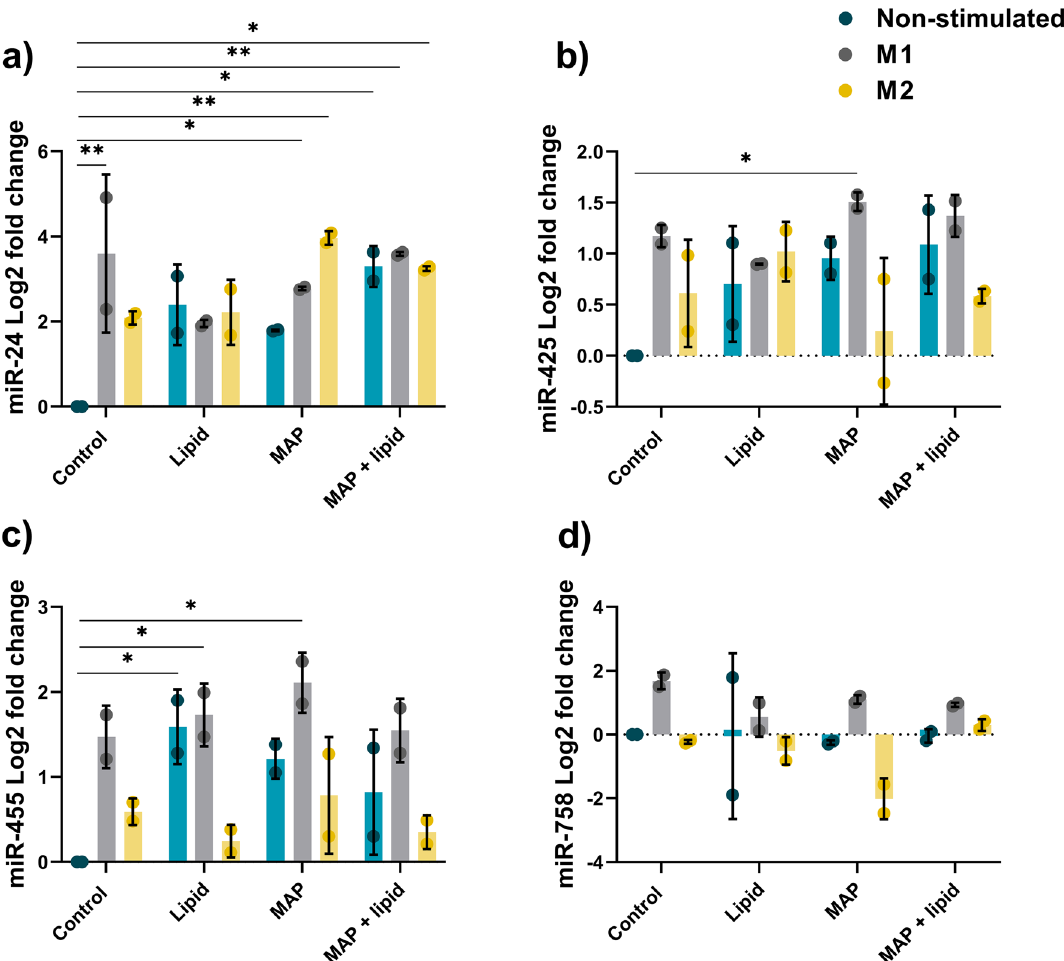
Figure 4. miRNA expression in MAP infected murine macrophages. RAW264.7 macrophages were infected with MAP with or without lipid supplementation. miRNA expression was analysed by qPCR at 24 hpi. ( a ) miR-19b fold change, ( b ) miR-455 fold change, ( c ) miR-425 fold change, ( d ) miR-758 fold change. Columns represent the mean fold change from control uninfected cells and error bars indicate the standard deviation, while asterisks indicate significantly different fold changes (*p ≤ 0.05, **p ≤ 0.01, ***p ≤ 0.001, ****p ≤ 0.0001). Graph is representative of 2 biological replicates and 2 technical